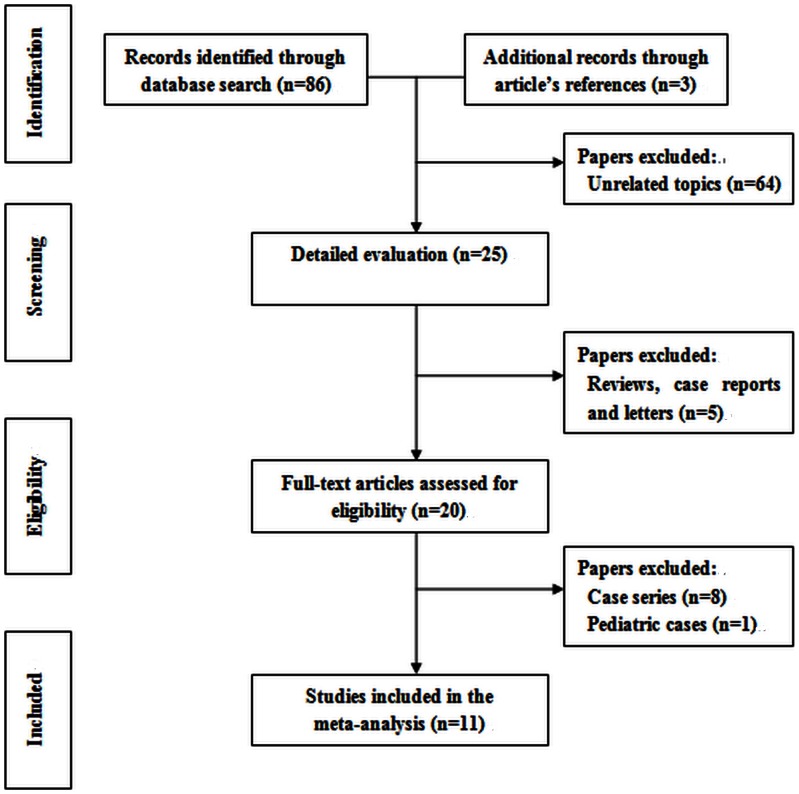
Search and study selection process.